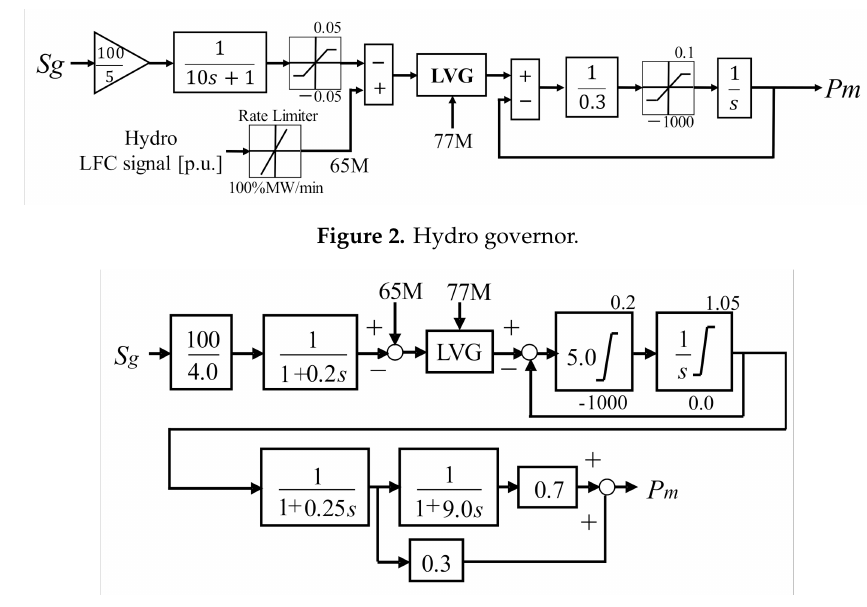
Figure 3. Thermal governor.